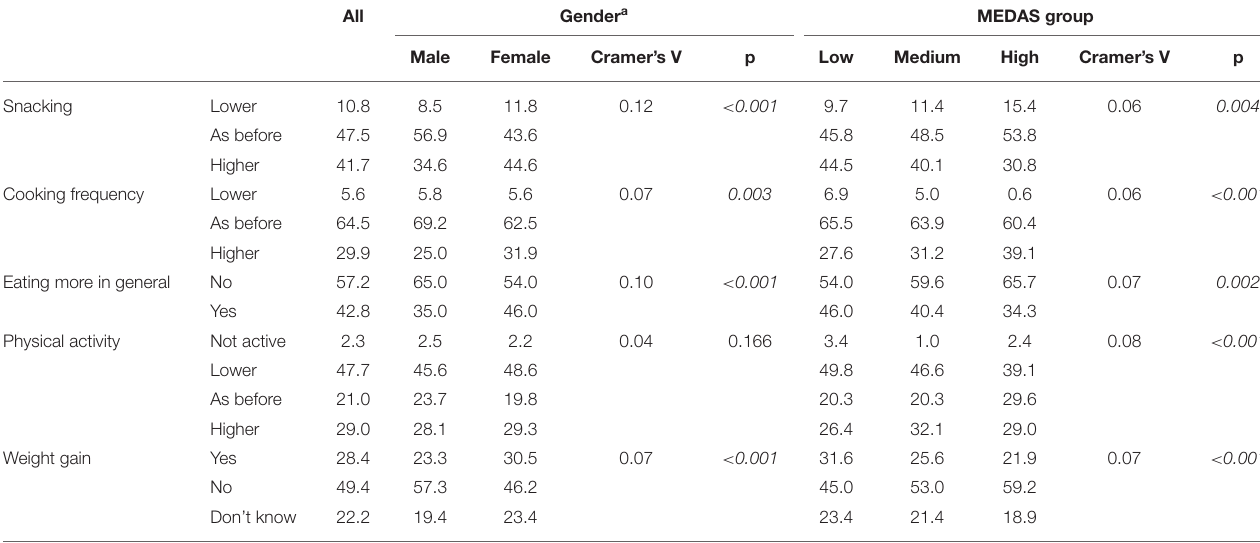
TABLE 2 | Reported changes (%) in intake of selected product categories during lockdown, at an overall level as well as by gender and adherence to MedDiet. All Gender a MEDAS